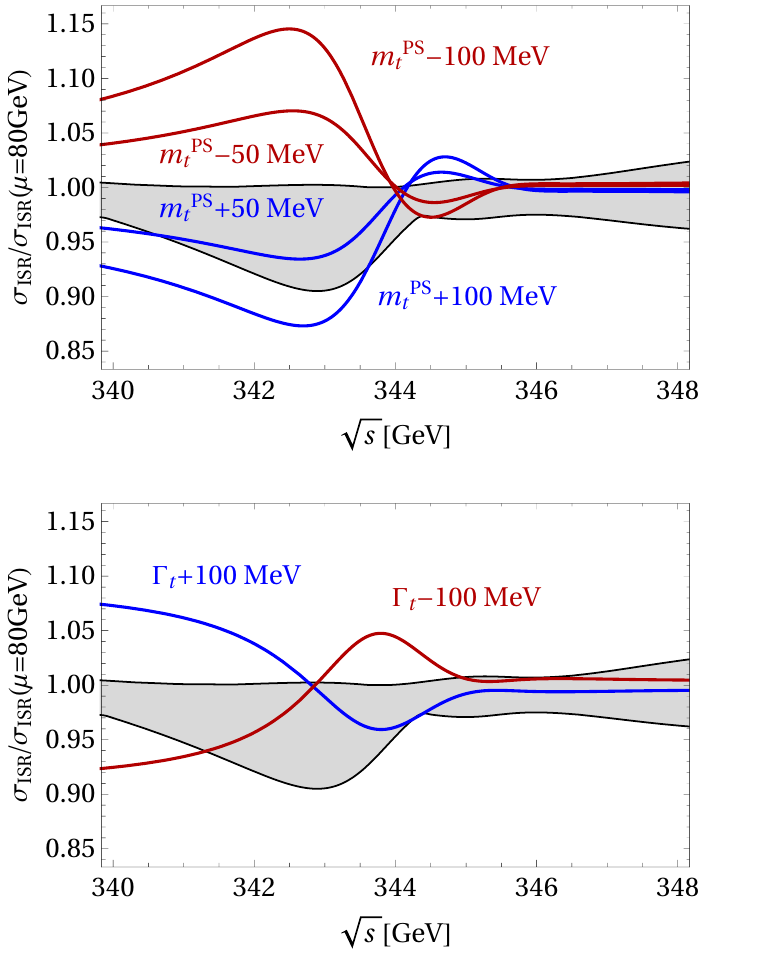
Figure 16 . The cross section for the input values (7.1) up to variations of the top mass (top panel) and top width (bottom panel) is shown in comparison the uncertainty band from scale variation (cf. (cid:12)gure 10). The prediction is normalized to the full cross